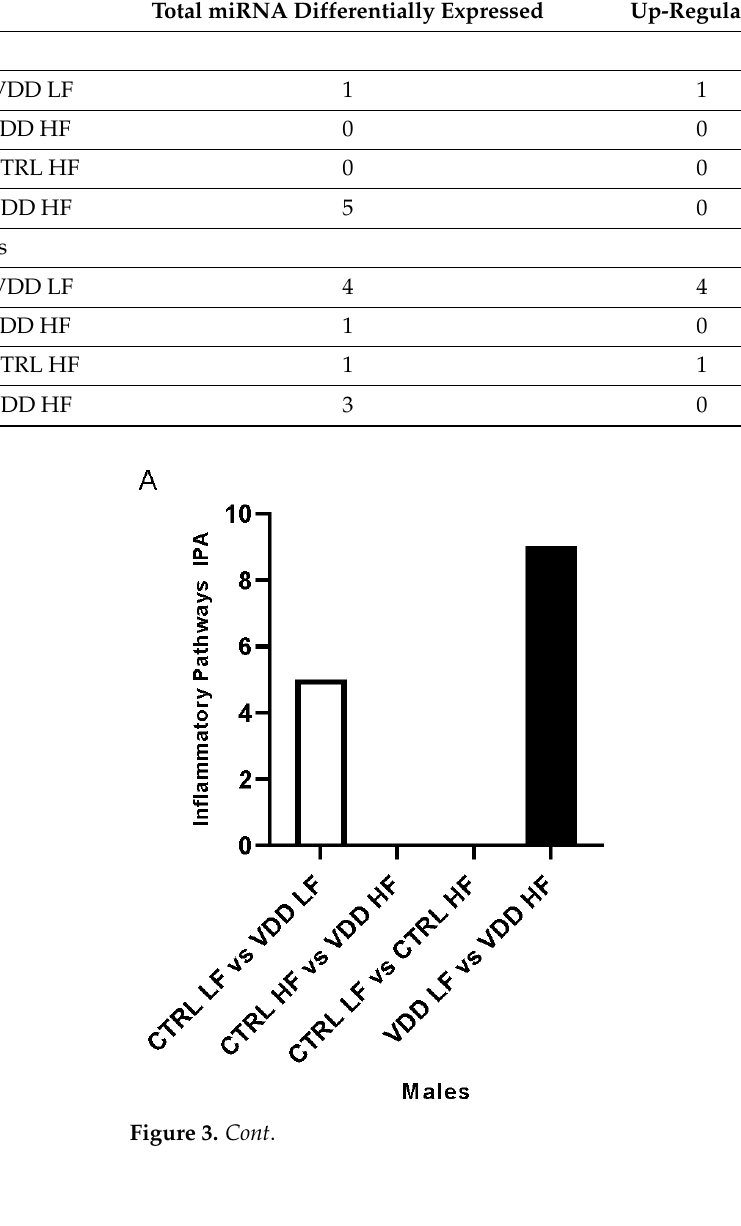
Figure 3. Inflammatory pathway linked to miRNA profile in adipose tissue of the offspring. Quan- titative representation of miRNA expression in inflammatory pathways resulting in differential miRNA expression in retroperitoneal adipose tissue of the male offspring ( A ) and female offspring ( B ), using Ingenuity Pathway Analysis (IPA). Two sets of data were employed. The first is CTRL LF vs. VDD LF and CTRL HF vs. VDD HF. The second data set is CTRL LF vs. CTRL HF and VDD LF vs. VDD HF. Bars in white correspond to up-regulated pathways and bars in black for down-regu- lated pathways. TargetScan (genes were selected with an Aggregate PC 90%) and mirDB (genes were selected with a target score 80%) were used to identify inflammatory miRNA and create a predicted mRNA target list. The miRNA inflammation-related pathways in white adipose tissue were analysed using IPA. To assess the influence of the maternal diet and/or the adult diet on in- flammation pathways in the offspring, quantitative analyses were carried out.